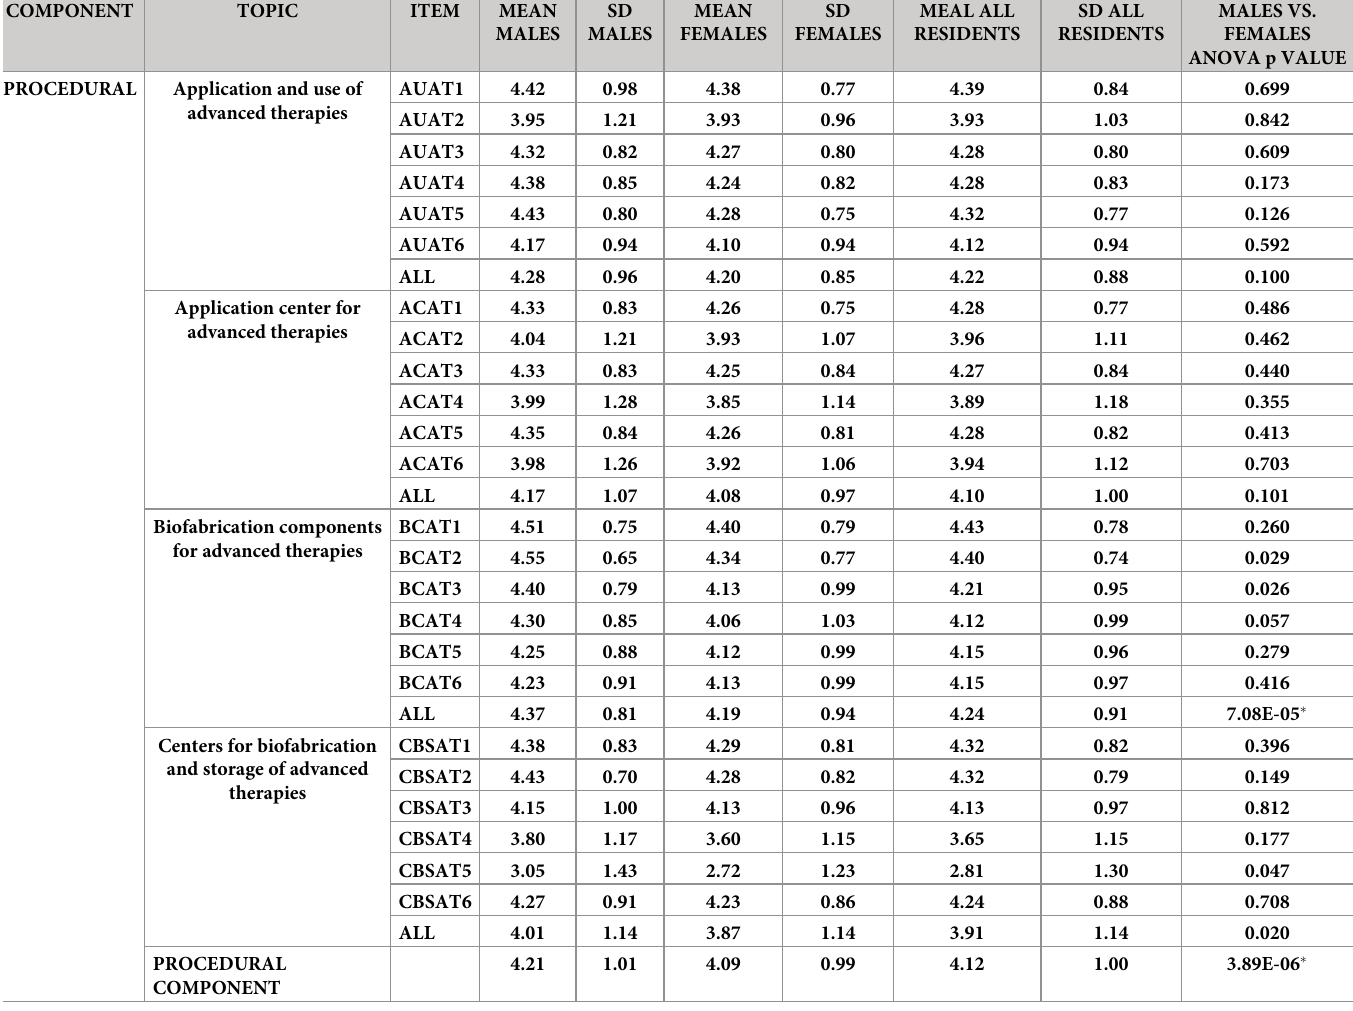
Table 3. Mean values and standard deviations (SD) for the procedural component and for each topic and each item included in this component. In each case, results are shown for male and female residents separately and for all residents together. The last column shows the statistical p value for ANOVA comparisons between